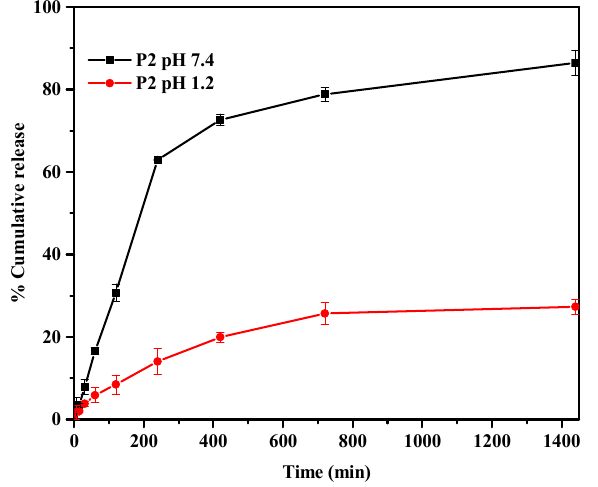
Figure 8. In vitro release behavior of the PPK hydrogel (P2) in pH 1.2 and 7.4 buffer media at 37 °C. For all formulations, n and k were calculated using the least square method, and the percentage of 5-FU release from PPK hydrogel was plotted as a function of log